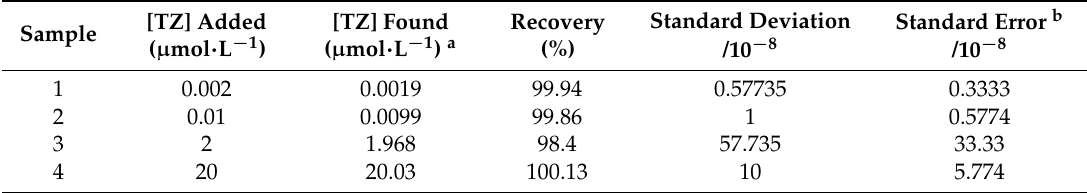
Table 3. Comparison of TZ determination at various modified electrodes-based literature